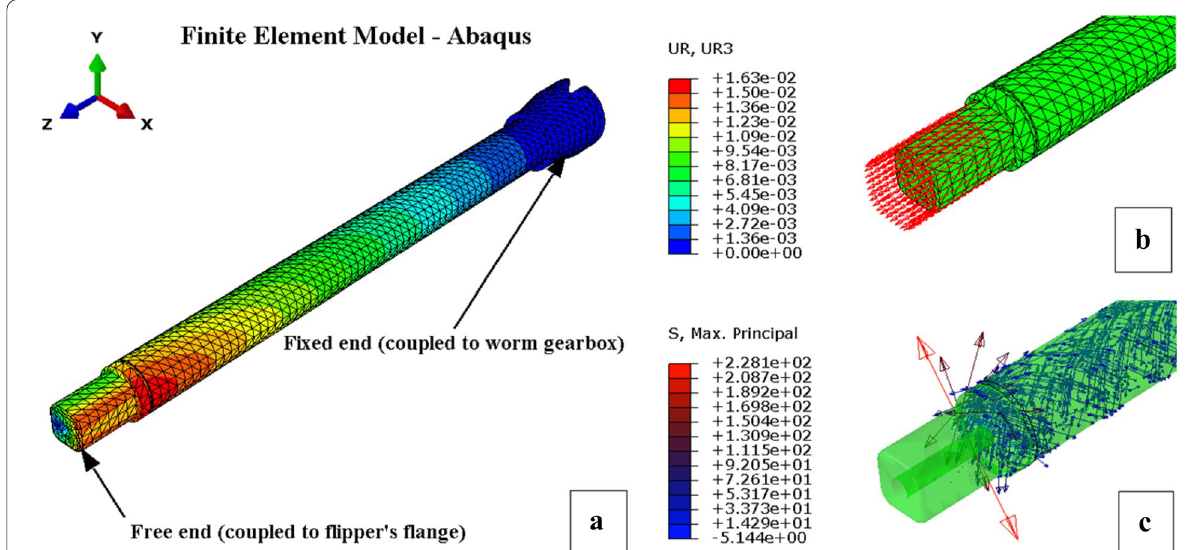
Fig. 12 Finite element model of a flipper’s driving shaft in